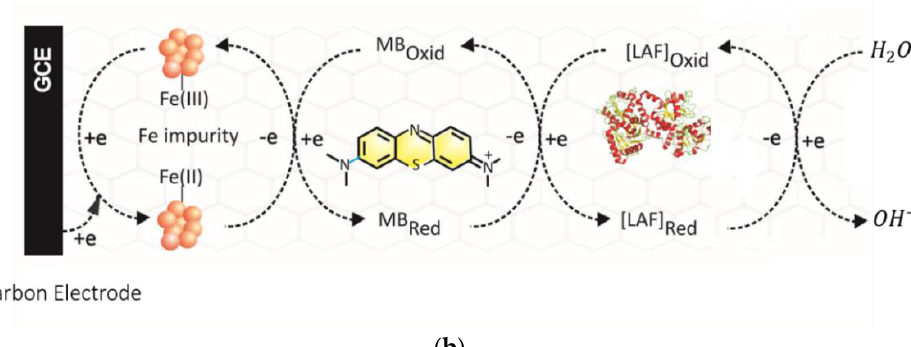
Figure 6. Electrochemical biosensor for the detection of lactoferrin ( a ) affinity sensor with anti-lactoferrin modified on the surface of electrode; ( b ) nonaffinity electrochemical sensor, detecting changes of potential in redox reaction between lac- toferrin and hydrogen peroxide (reprinted with permission) [116] .